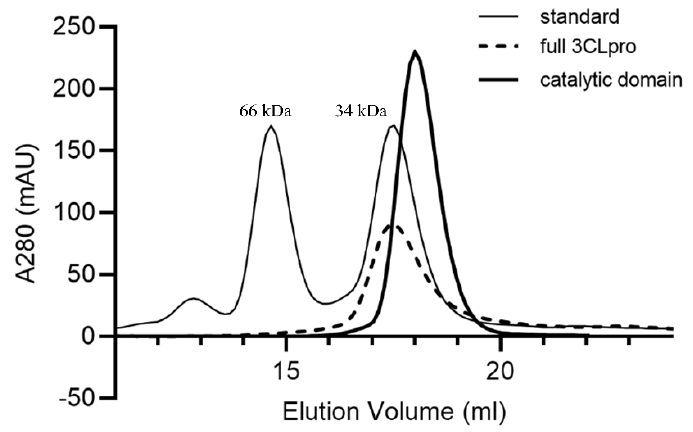
Figure 3. The size-exclusion chromatography of SARS-CoV-2 3CLpro. The thin line represents the makers (human albumin and TCTP), the thick line represents the catalytic domain, and the dotted line represents the full 3CLpro.